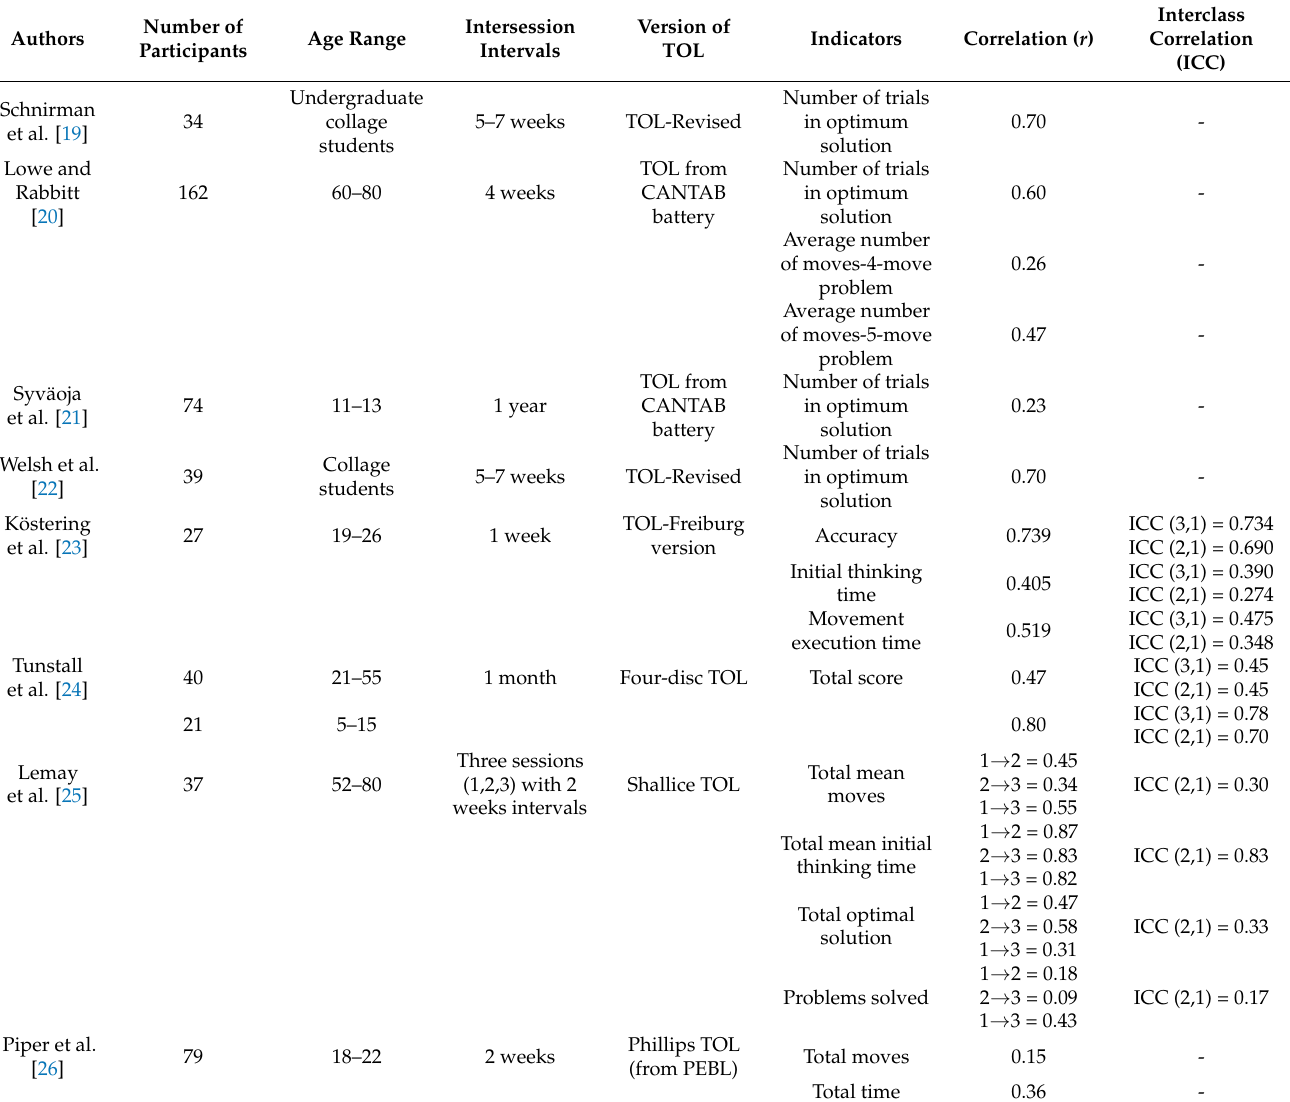
Table 1. Survey on studies for test-retest reliability for Tower of London